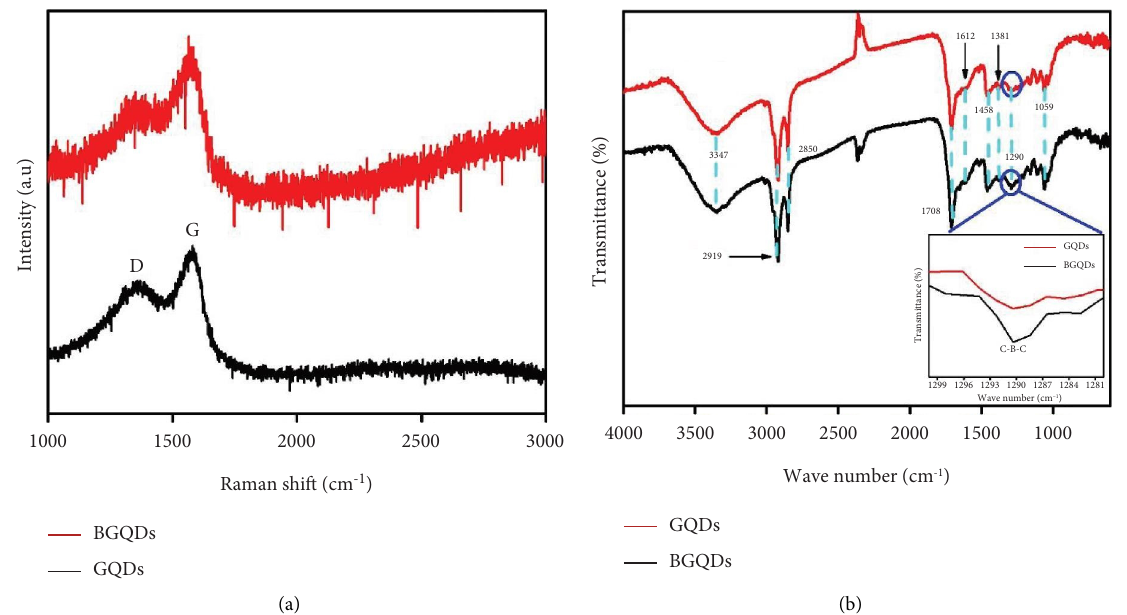
Figure 5: (a) Raman and (b) FTIR spectrum of GQDs and